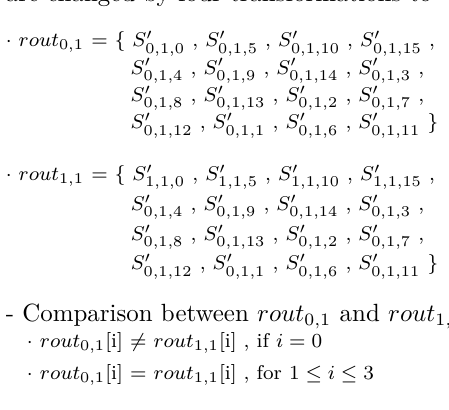
· S 0 , 1 ,k 6 = S 1 , 1 ,k , if k =